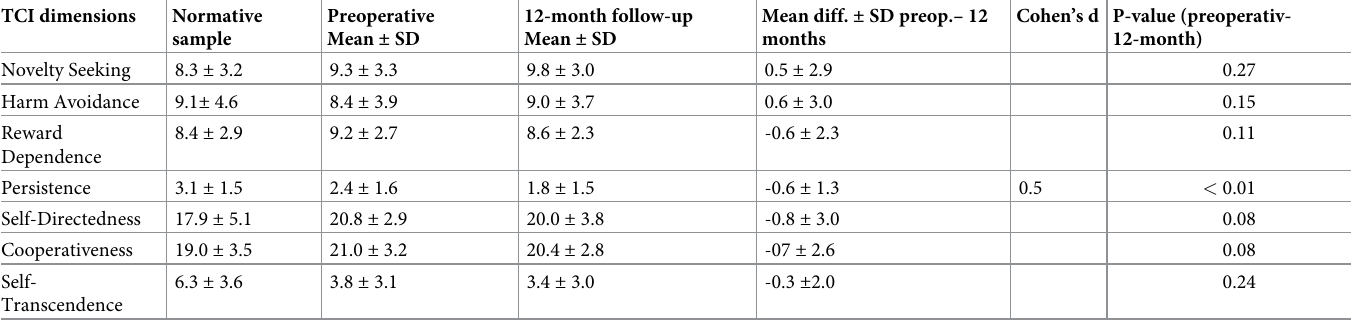
Table 2. The Temperament and Character Inventory (TCI-125) scores of normative sample, preoperative scores and at 12 months follow-up in our study population.